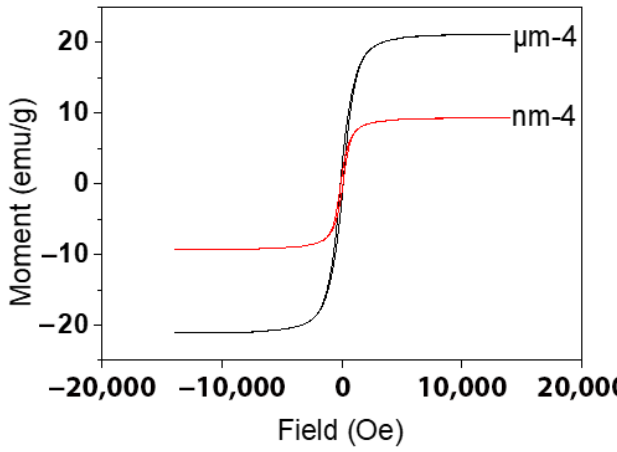
Figure 3. Hysteresis loops of the microcomposite scaffolds of the μ m-4 and nm-4 samples.